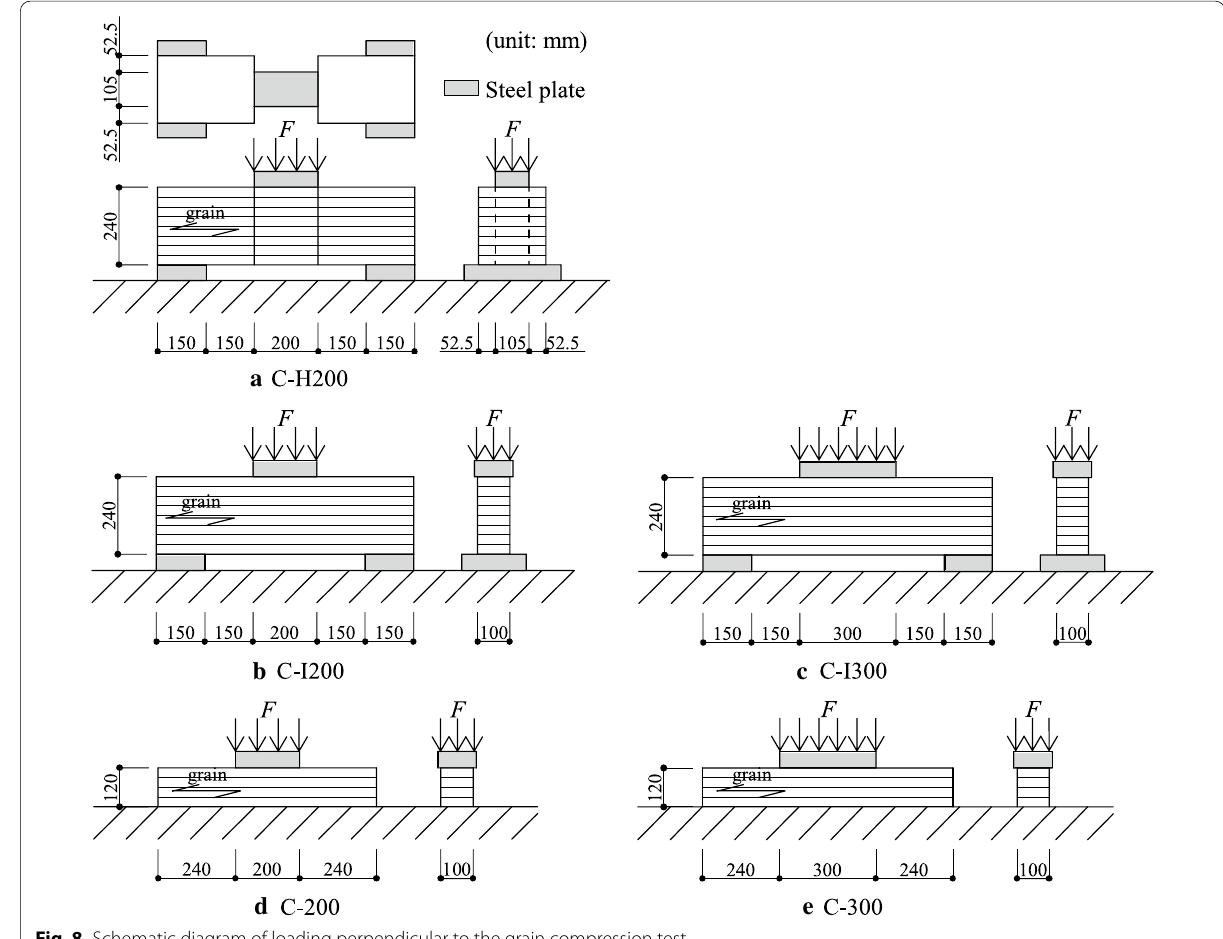
Fig. 8 Schematic diagram of loading perpendicular to the grain compression test